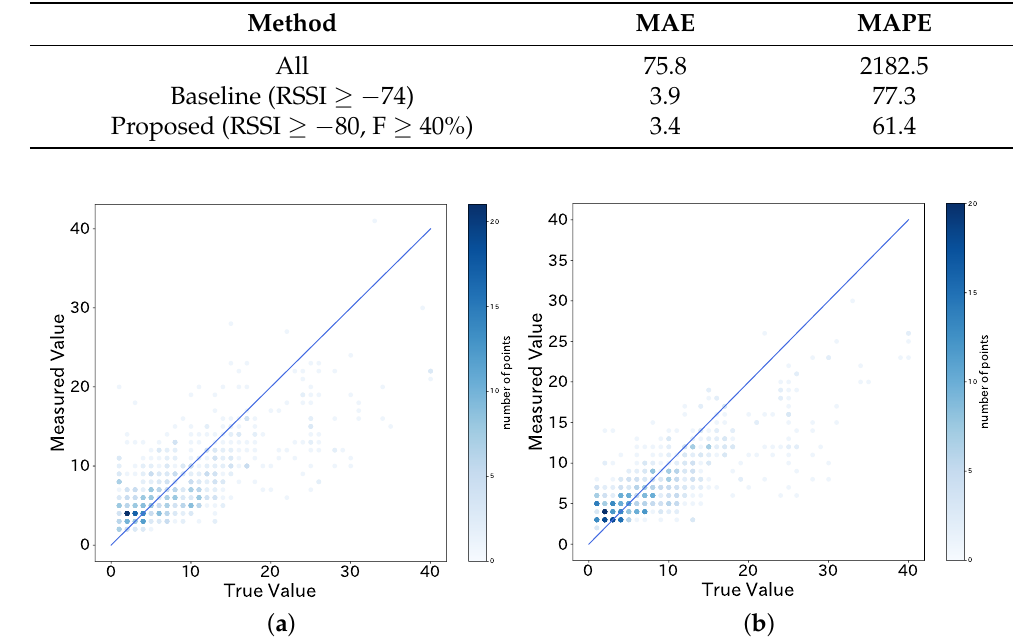
Figure 7. Values estimated by threshold (number of BD addresses) versus true values (number of passengers). ( a ) Baseline (RSSI ≥ − 74); ( b ) Proposed (RSSI ≥ − 80, F ≥